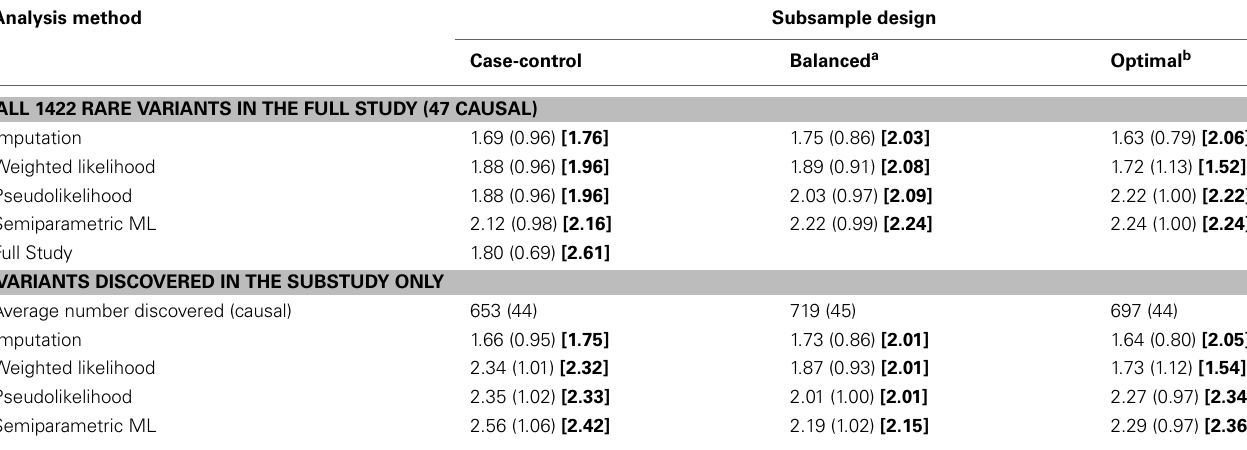
Table 1 | Parameter estimates (SEs) [Wald Z -tests] for the simulated two-phase sequencing data using the imputation, weighted likelihood, Breslow-Cain pseudo-likelihood, and Breslow-Holubkov semiparametric maximum likelihood